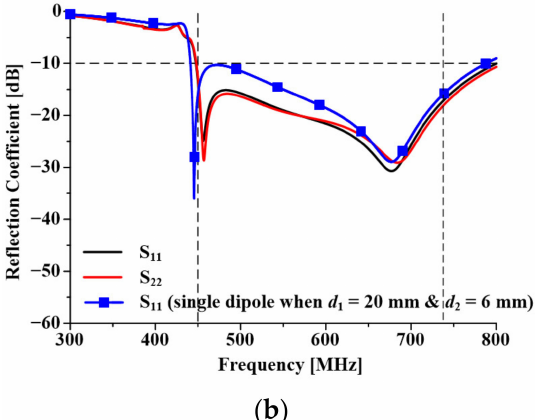
Figure 10. Dual-polarization half bow-tie dipole antenna: ( a ) geometry of antenna and ( b ) simulated reflection coefficient performances.